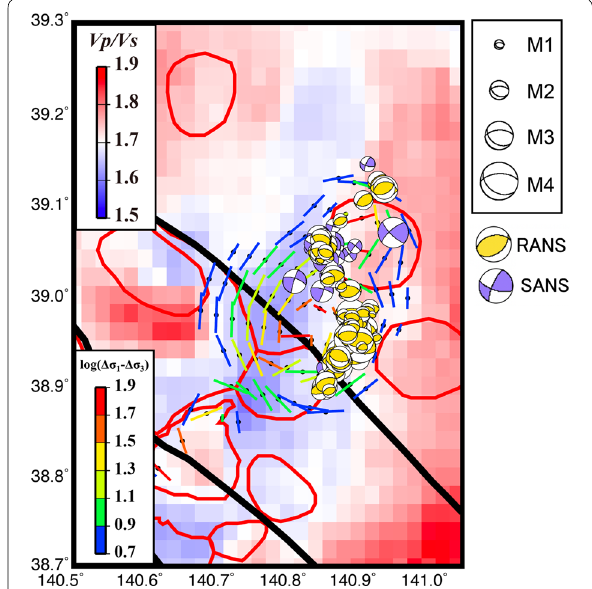
Fig. 7 Distribution of V p /V s ratios, events with N–S compression, and axes of maximum compressive stress change. Distribution of V p /V s at 4.5 km depth is from Okada et al. (2012). Focal mechanism solutions with N–S compression from category A events (RANS and SANS) in the depth range 3.25–6.25 km are shown. Bars represent axes of the maximum compressive stress changes (Δ σ 1 ) caused by the mainshock at 5-km depth projected to the surface (Yoshida et al. 2014b). The color of each bar represents to the magnitude of the calculated differential stress change. Only differential stress changes 5 MPa are plotted. In the title of the bottom-left scale bar, ≥ “log” means the common (base 10) logarithm and the units are MPa. The value of 0.7 on the logarithmic scale corresponds to 5 MPa and 0.9 corresponds to 8